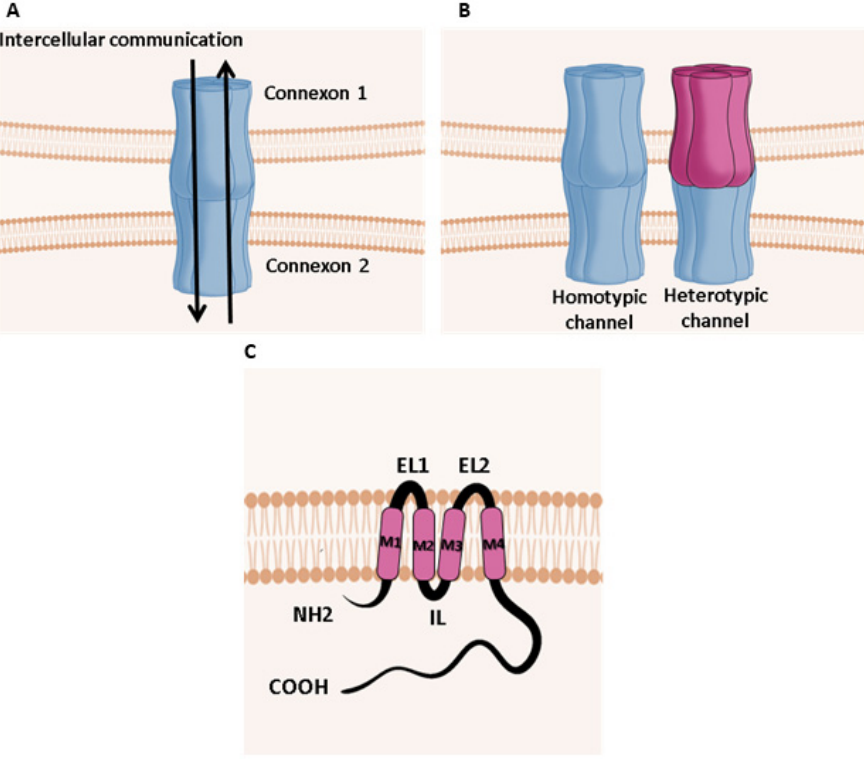
Figure 1. Gap junction. ( A ) Schematic representation of gap-junctional channel. ( B ) Schematic representation of homotypic and heterotypic gap-junctional channel. ( C ) Schematic representation of the connexin structure.